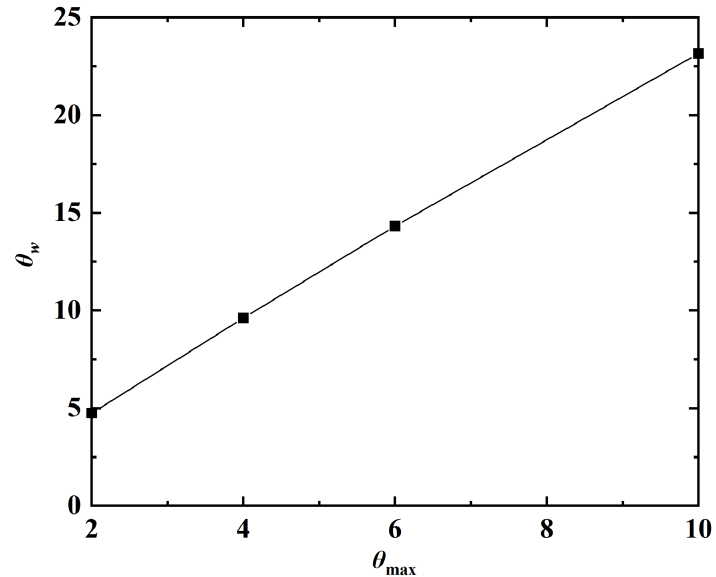
Figure 21. Relation between θ max and θ w . The black solid line in the line of best